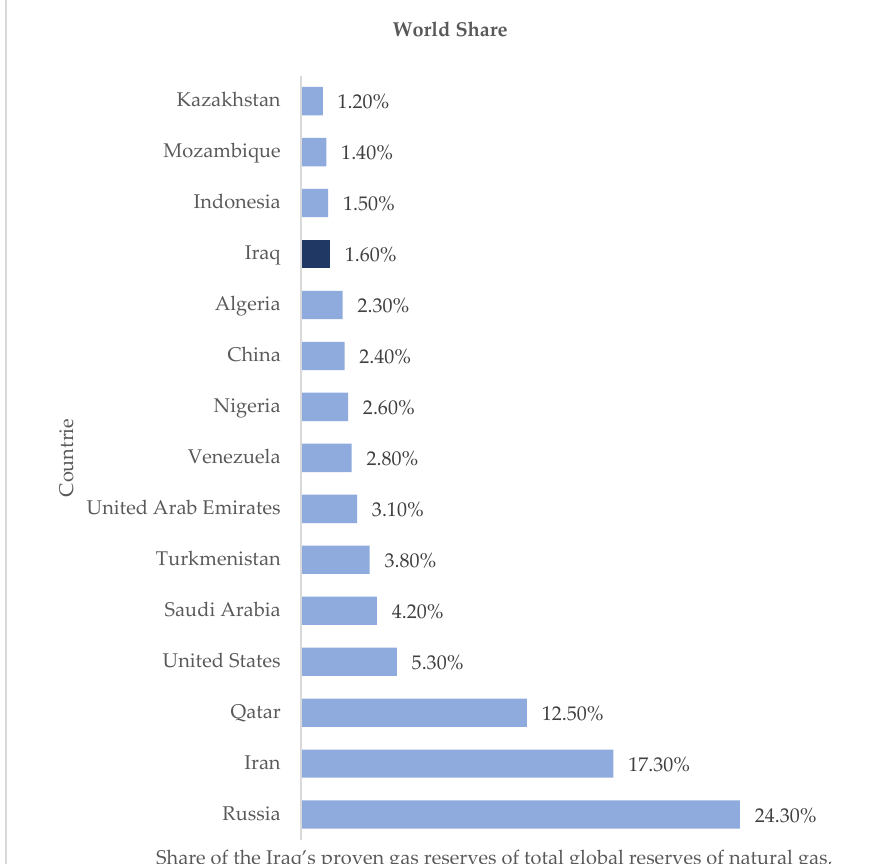
Figure 10. Share of the Iraq’s proven gas reserves of total global reserves of natural gas in 2020, % [36].